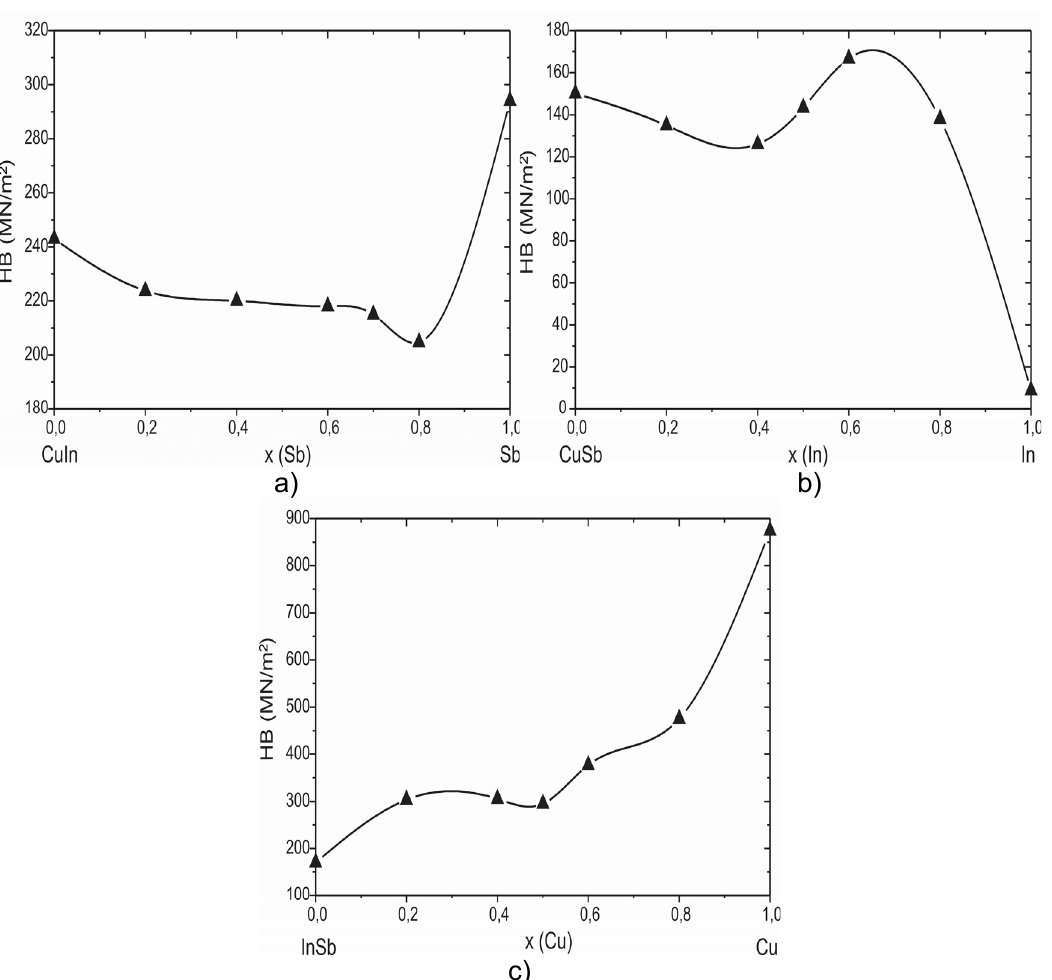
Figure 7. Hardness of alloys of ternary Cu-In-Sb system, a) vertical Sb-CuIn section, b) vertical In-CuSb section and c) vertical Cu-InSb